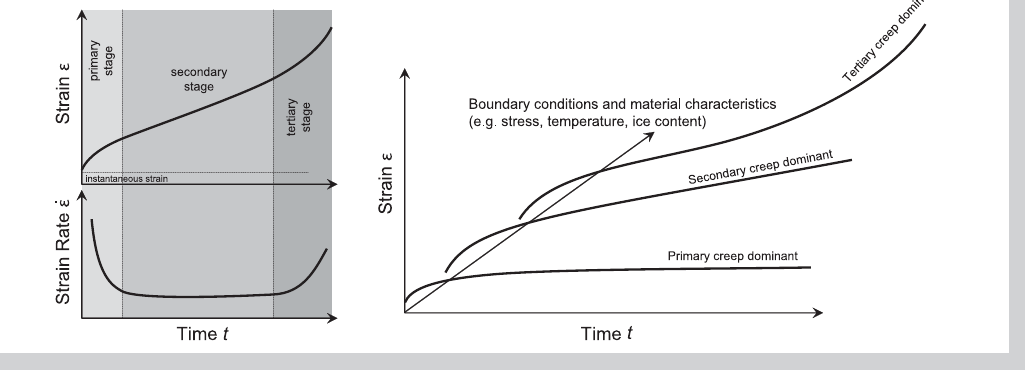
Figure 9: Creep-curve definitions (a) and variations (b) [e.g.